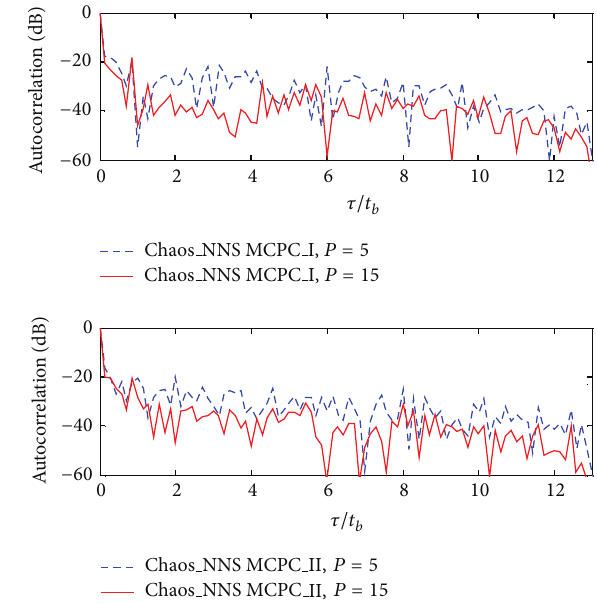
Figure 8: Influence of subcarrier number on autocorrelation.